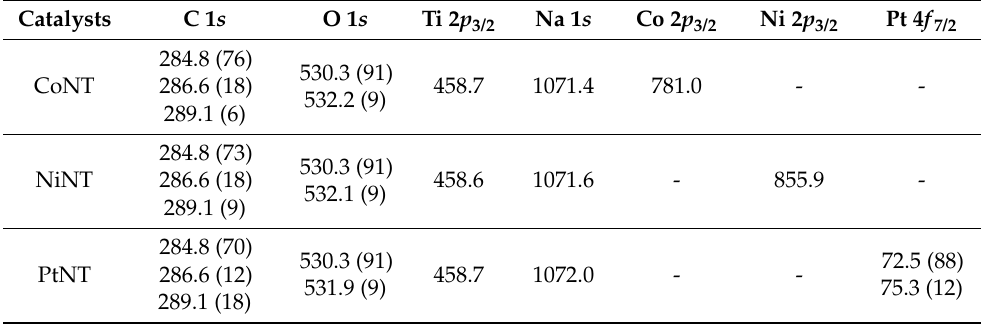
Table 3. Binding Energies (in eV) of the C 1 s , Ti 2 p 3/2 , O 1 s , Na 1 s , Co 2 p 3/2 , Pt 4 f 7/2 and Ni 2 p 3/2 signal for the studied